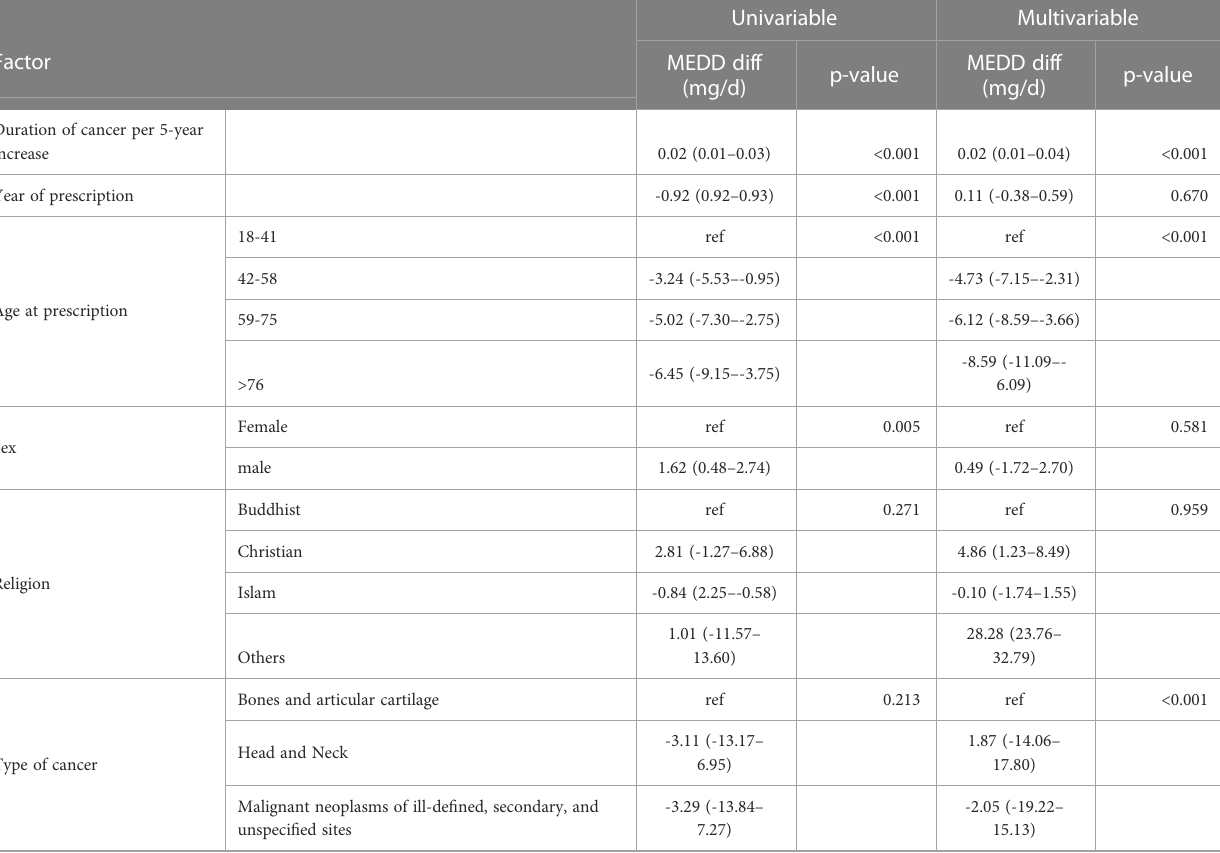
Univariable Multivariable MEDD diff MEDD diff p-value p-value (mg/d) (mg/d)